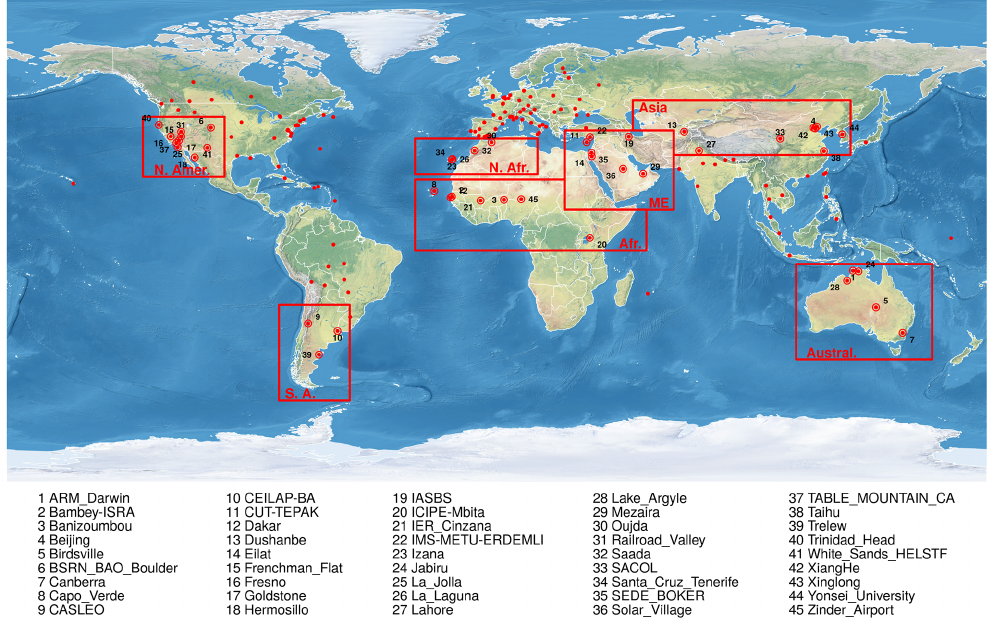
Figure 8. AERONET stations and regions of interest used for the evaluation. Stations with data for 120 or more days distributed over at least 9 months of 2011 (red dots) are considered, yielding 45 stations within the regions of interest (labelled).